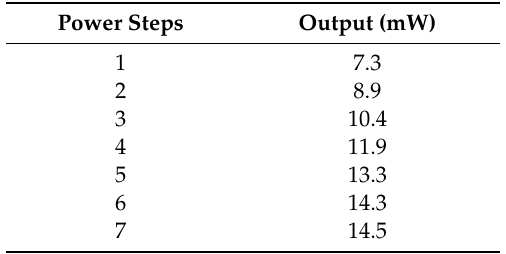
Figure 3. ( a ) Spectral presentation of the incident UV irradiation intensities and ( b ) spectral presentation of the forward luminescence of the QD250 when irradiated with the di ff erent incident UV intensities. Table 2. Measurements of the output UV radiation power.